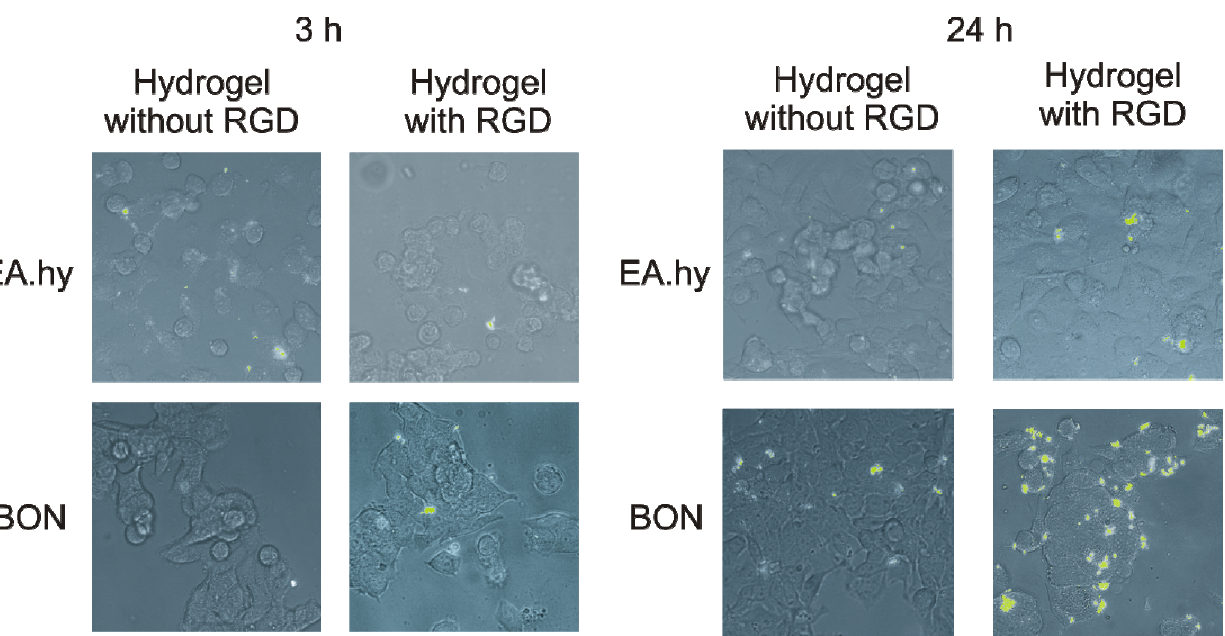
Figure 4. Superimposed transmission and fluorescence photographs of EA.hy endothelial (top) and BON cancer cells (bottom) that were incubated with p EtOx -p Dc = Ox -p TMBO - FITC hydrogels for 3 h (left) and 24 h (right), 100 50 30 0.1